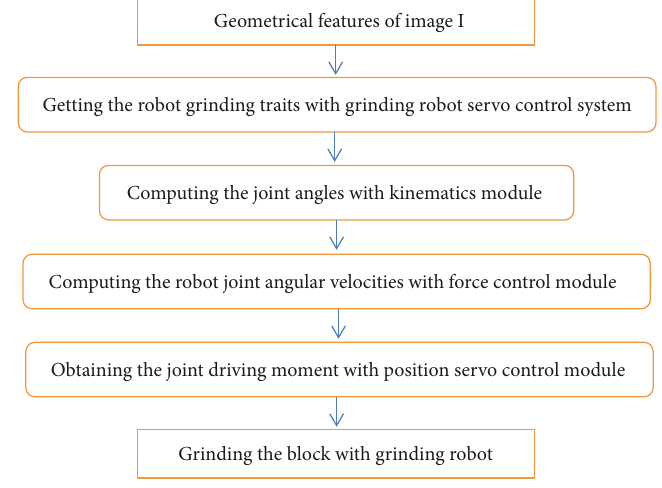
Figure 7: The working process algorithm of controlling